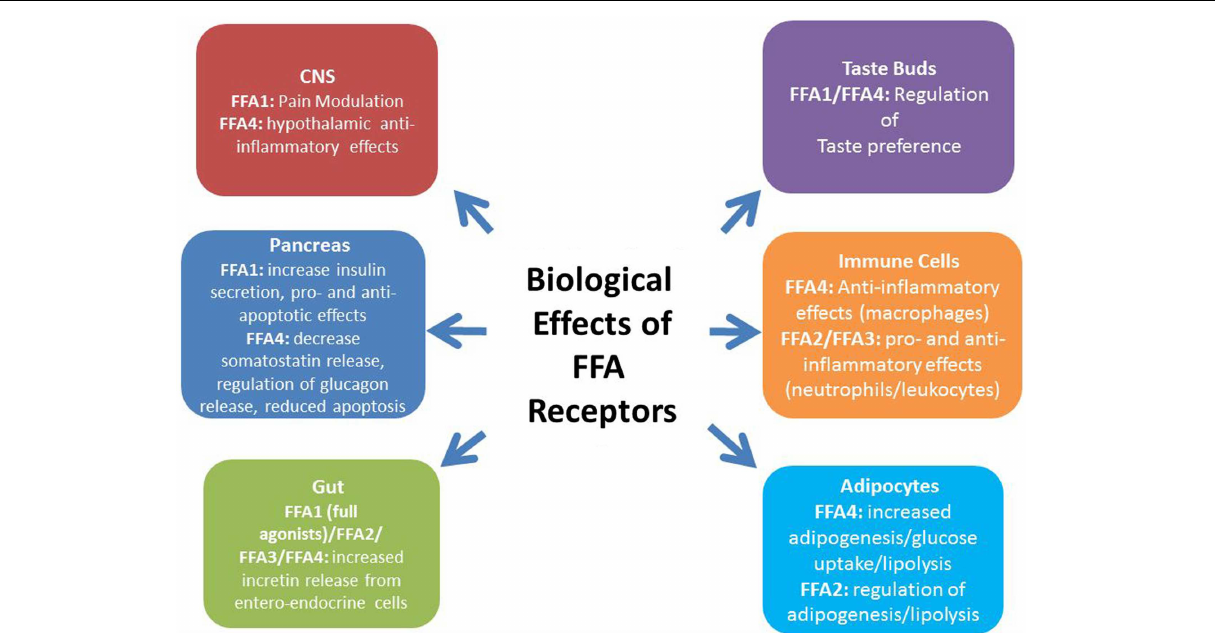
FIGURE 1 |The biological effects of FFA receptors . Dietary FFAs, such as ω -3 fatty acids from fish oils and SCFAs derived from the fermentation of dietary fiber, have profound effects on metabolic and inflammatory processes associated with obesity andT2D.These effects have, at least in part, been attributed to the activation of free fatty acid receptors (FFA1–4), leading to a great deal of interest in the development of synthetic FFA receptor agonists for the treatment of metabolic disease. Agonism of the long-chain FFA receptor FFA1, the most fully characterized of these receptors, improves glucose-stimulated insulin secretion from the pancreas. Additionally, full agonists of this receptor increase incretin release from the gut, thereby indirectly increasing pancreatic insulin secretion, as well as improving systemic insulin sensitivity and promoting satiety. Agonism of another long-chain FFA receptor, FFA4, is associated with incretin release from the